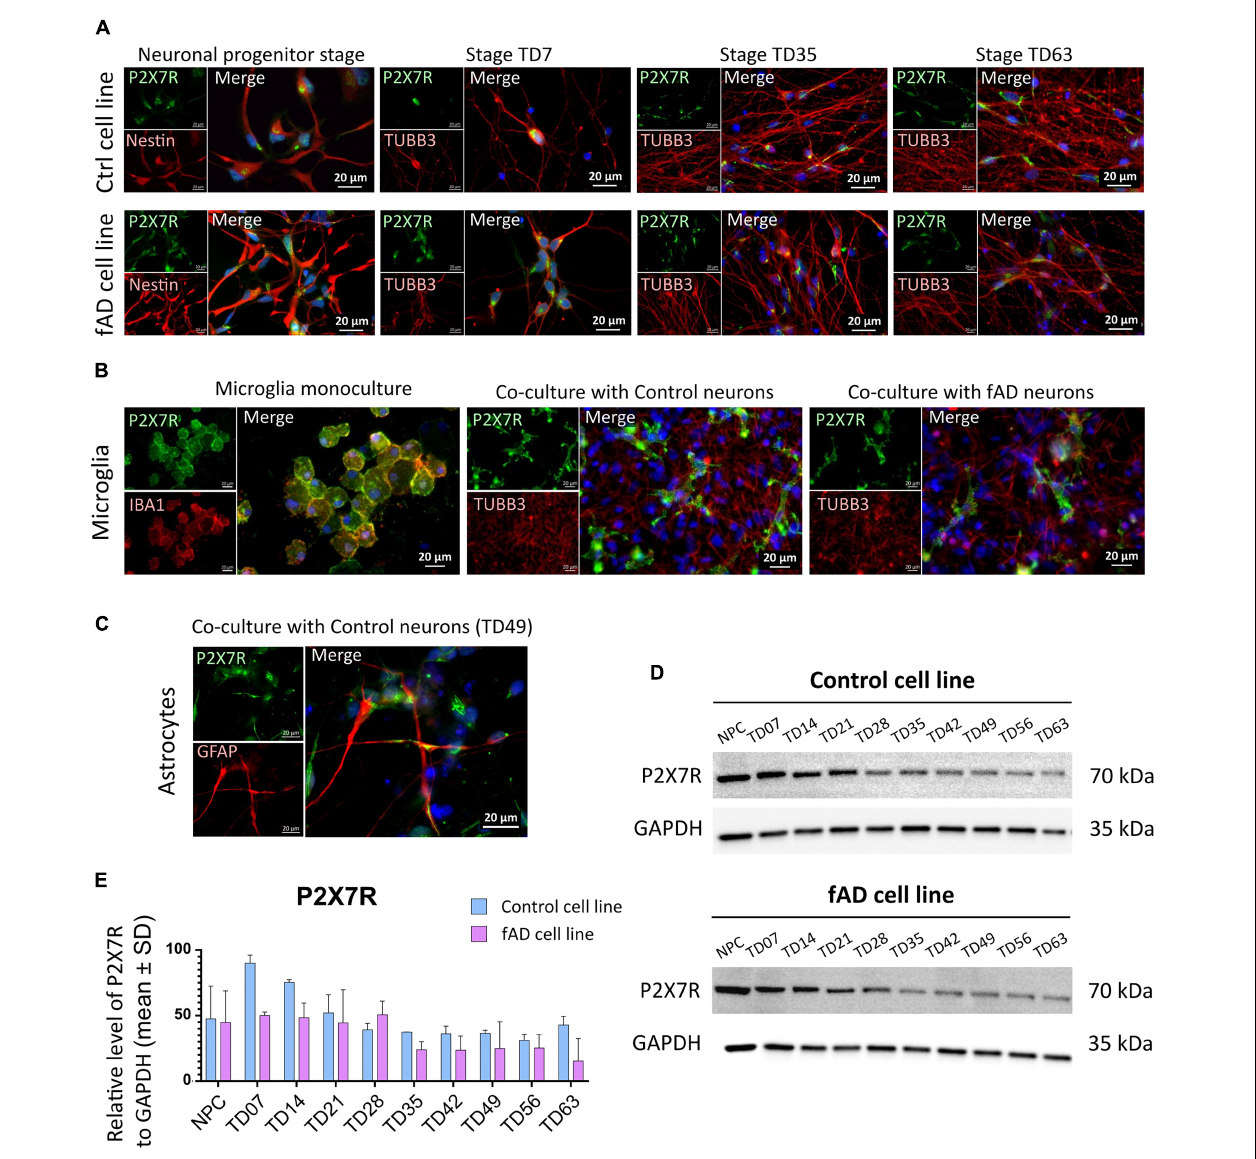
FIGURE 5 | Detection of the P2X7R in hiPSC-derived neuronal and microglia-like cell cultures. Immunocytochemical detection of P2X7R in different differentiation stages of control and fAD hiPSC-derived neurons (A) show the presence of the P2X7 receptor (green) in early stages of neuronal differentiation (NPC and TD07) and weaker signal in later differentiation stages (TD35, TD63). In contrast, a strong signal was detected on hiPSC-derived microglia (B) in both the early stage of microglial maturation in monoculture, as well as in co-culture with neurons (both control and fAD). Detection of coexpression of P2X7R (green) with GFAP (red) positive astrocytes (C) . The pictures are representative of at least three experiments performed on three independent cell cultures. For Western blot analysis 10 µ g of protein was loaded on the gel. Representative pictures of the results (D) show the presence of a positive signal for P2X7R protein in all neuronal samples, with signal intensity decreasing along with the differentiation time points (D) . Densitometric analysis of the Western blot detection illustrates the decrease in signal intensity. The analysis did not show a significant difference between the control and fAD cell line (E) . Western blot analysis was performed in biological triplicates and analyzed in at least three technical replicates. Error bars represent the mean ± SD of three